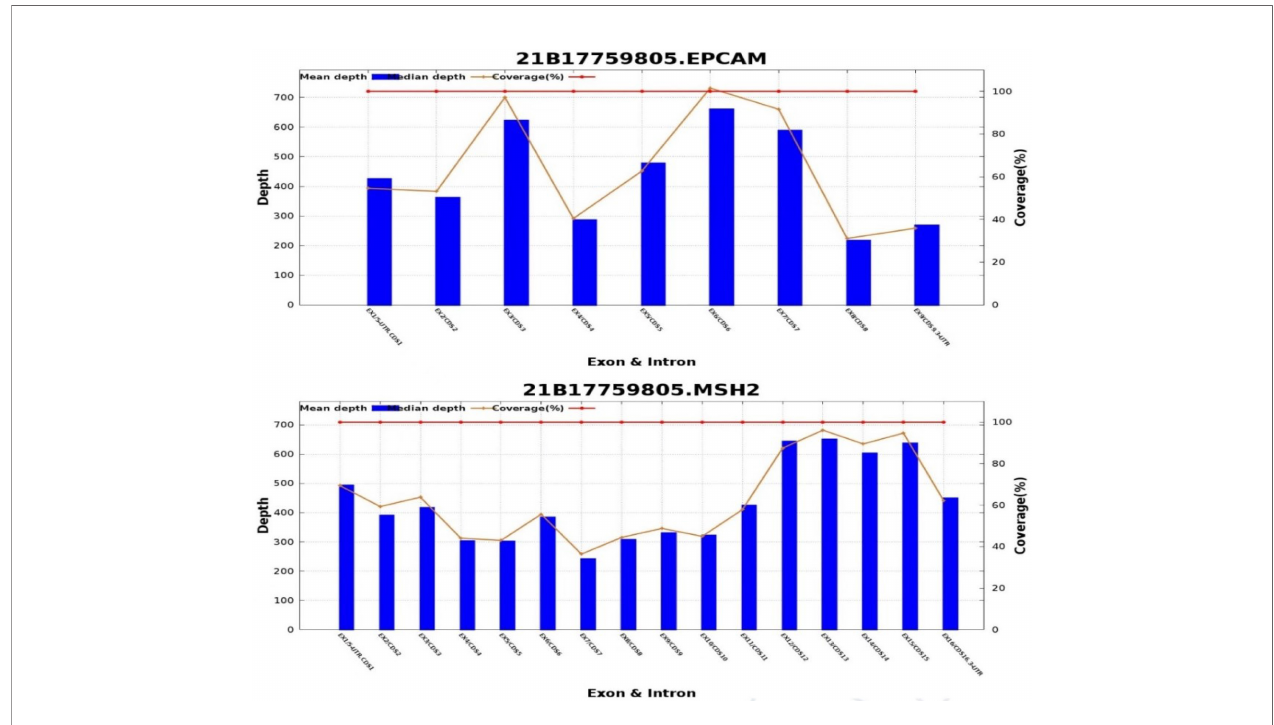
FIGURE 3 | The results of genetic analysis.